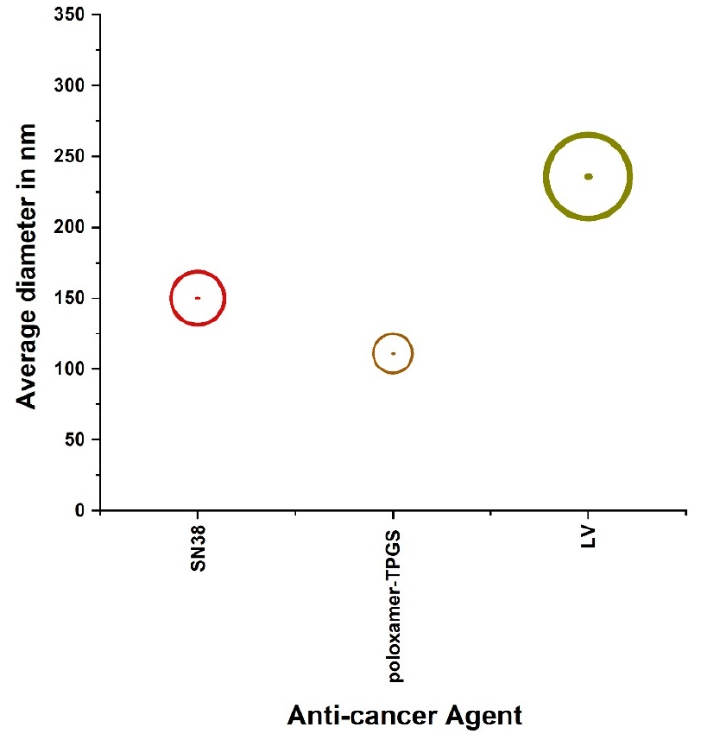
Figure 6. Average diameters of anti-cancer